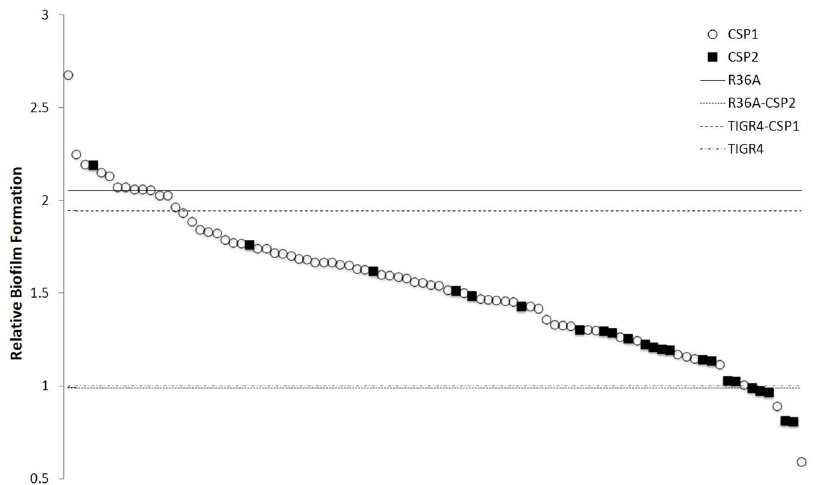
Figure 1. Distribution of pherotype-characterized strains according to the ability to form invitro biofilms. A total of 90 strains with pherotype CSP1 (n=67) or CSP2 (n=23) were screened for their ability to form biofilms in 96-well plates without the addition of synthetic CSP. After 24h of incubation, the resulting biofilm was measured by crystal violet staining. Each plotted value is an average of 9 replicates normalized by the average biofilm mass measured for TIGR4 strain (OD 595nm =0.147). Horizontal lines represent the relative biofilm formation of R36A, TIGR4 and their isogenic switched-pherotype mutant strains.